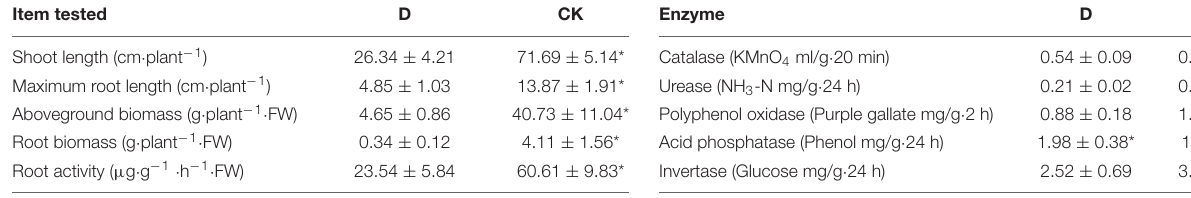
TABLE 3 | Soil enzyme activities in cropping obstacle soil (D) and healthy control soil (CK).